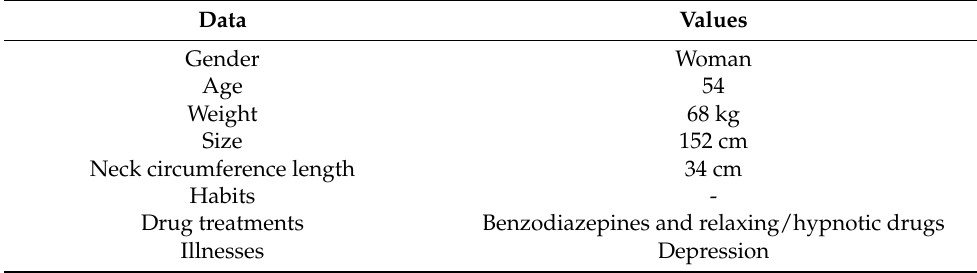
Table 15. Data on the patient to be